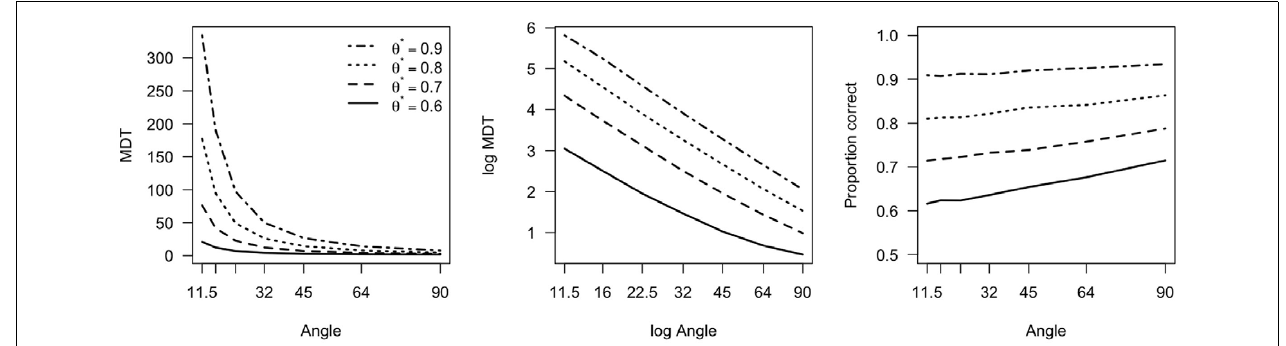
FIGURE 4 | Ideal observer model behavior as a function of the angular distance between alternatives, for four different response criterion